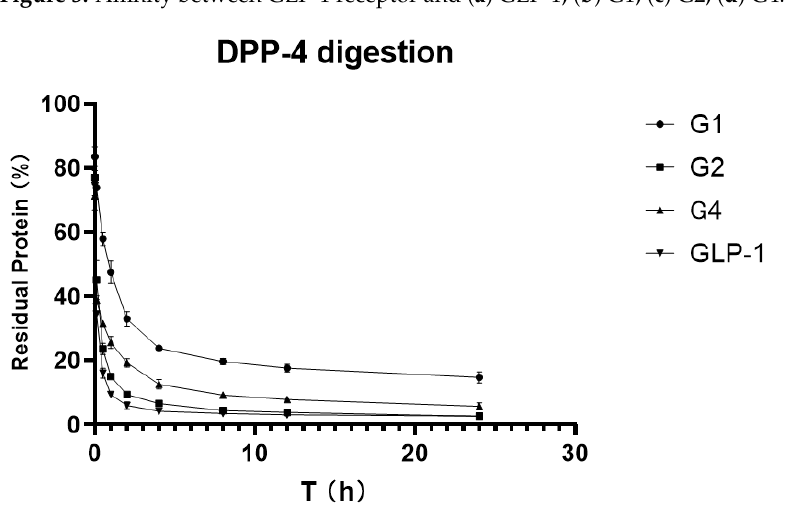
Figure 4. DPP-4 digestion curve. See also Table A1: Area Under Curve of DPP-4